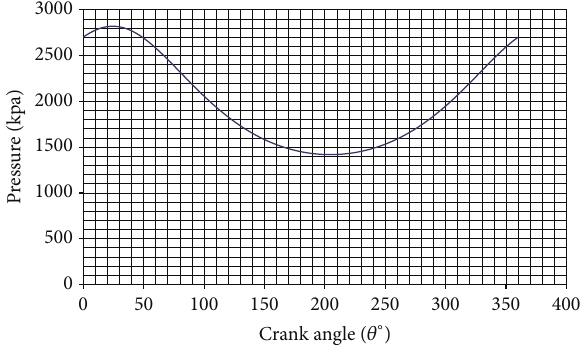
Figure7:Relationbetweenentirepressuresandchanginginvolume for Stirling engine.